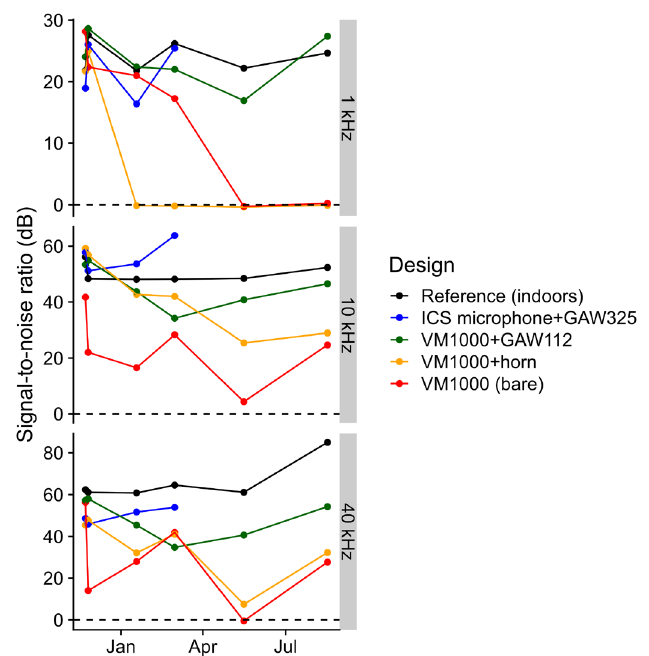
Figure 7. Change of signal-to-noise ratios of microphones protected with different attachments (GAW112 and GAW325 are acoustic vents) at different sound frequencies. Signal-to-noise ratio here is defined as the difference between the ambient sound level and the signal sound level. The acoustic GAW325 vent that protected the ICS-40720 microphone was pierced after the recording in